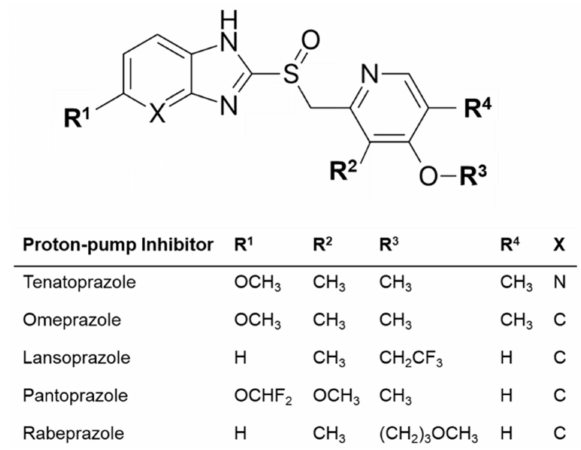
Figure 1. Chemical structures of common proton pump